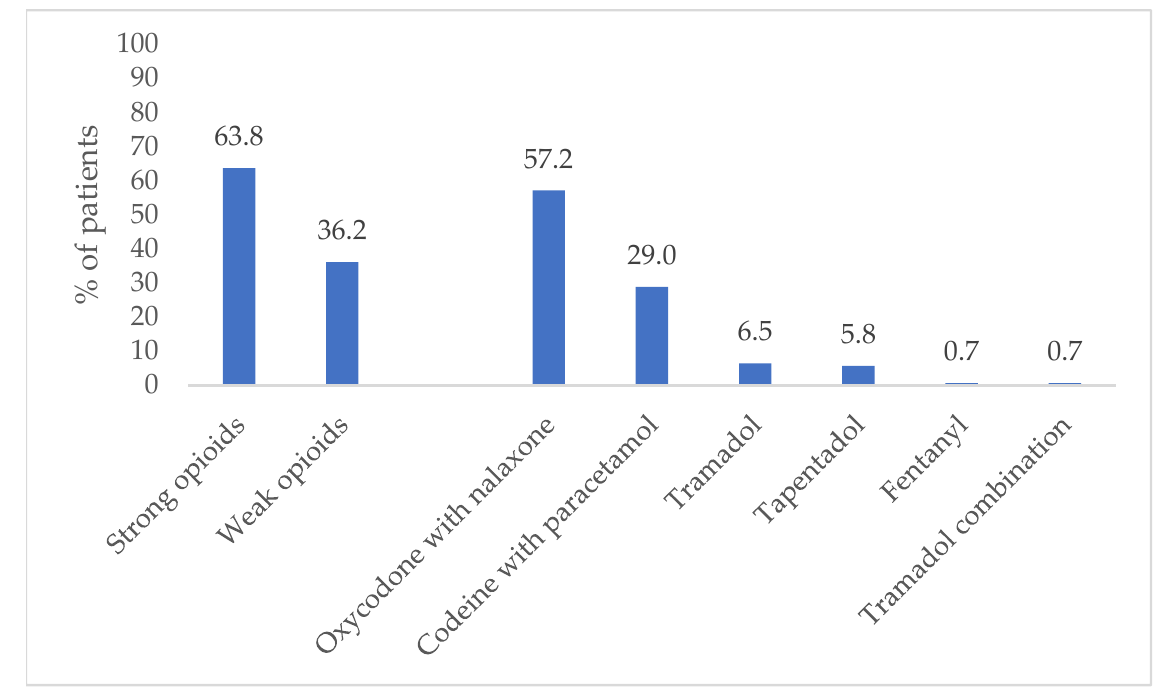
Figure 2. Percentage of patients with an opioid prescription. Table 2. Clinical and demographic factors associated with an opioid prescription (ref.